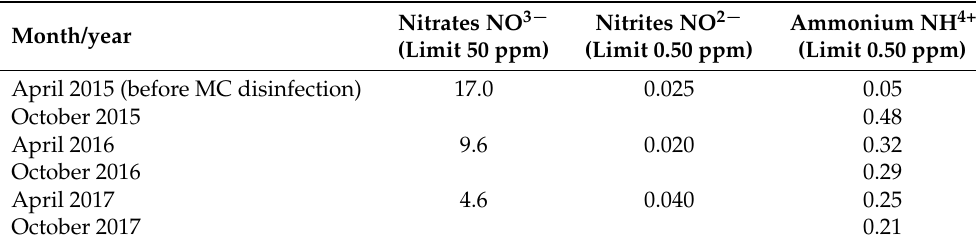
Table 3. Levels of ammonium, nitrates and nitrites at base line and during the treatment of the WSP with